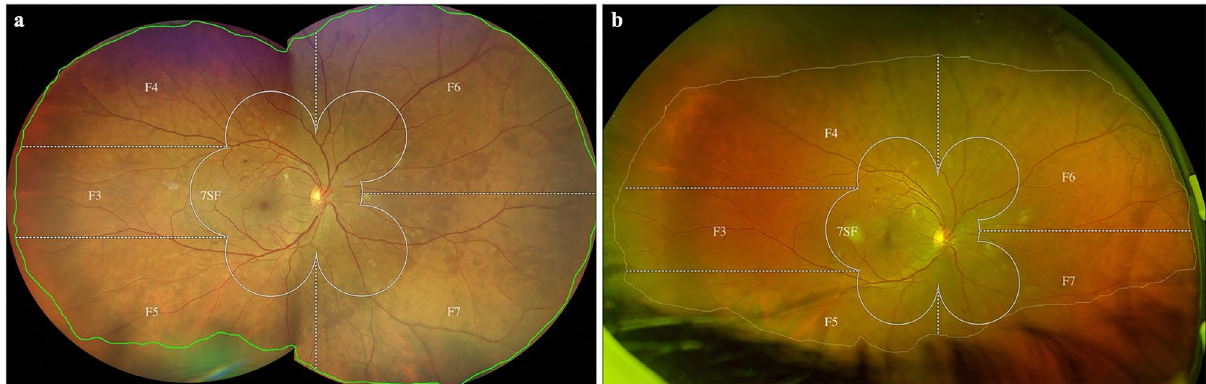
Figure 1. Ultra-widefield images acquired with the Clarus ( a ) and Optos ( b ). The total gradable area which excludes eyelashes, distortions, and blurriness is measured using the measurement tools on each device ( a : green line, b : yellow line). EDTRS 7 standard fields (7SF) and peripheral fields F3-F7 are used for classification of DR. Color differences due to imaging modalities are notable with the Clarus using “true color” due to white